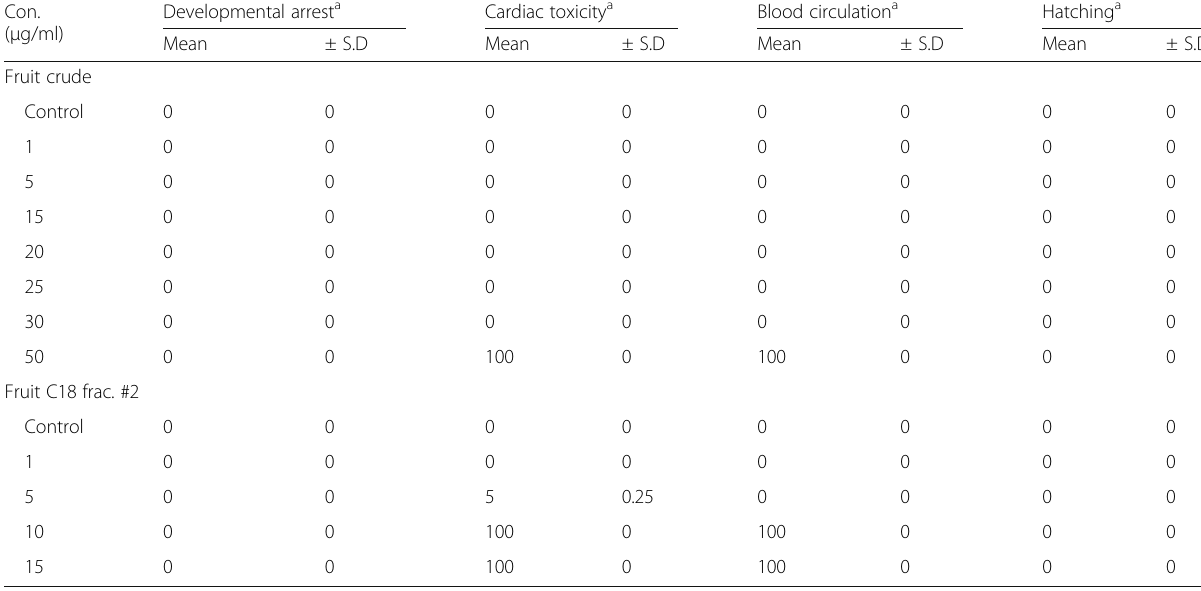
Table 4 Teratogenic dose response of zebrafish embryos exposed to crude and fraction of fruit extract of Momordica charanti at 72hpf